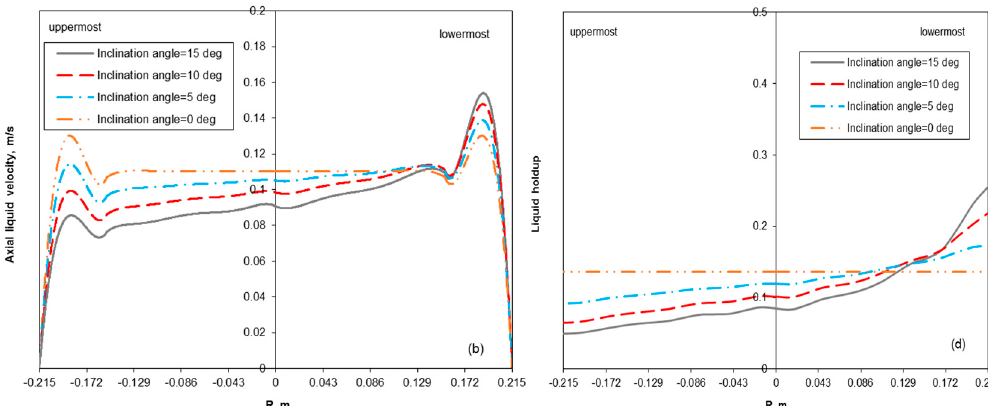
Figure 16. Steady-state radial profiles of cross-sectionally averaged liquid axial velocity ( a , b ) and liquid holdup ( c , d ) in x-axis (see Figure 1)—vertical and inclined seawater scrubbers (Packed-bed column with Raschig super-Rings; H = 5 m; z / H = 0.8; Pressure = 2.5 MPa): ( a , c ) Liquid superficial velocity = 0.035 m / s; ( b , d ) Liquid superficial velocity = 0.015 m / s.